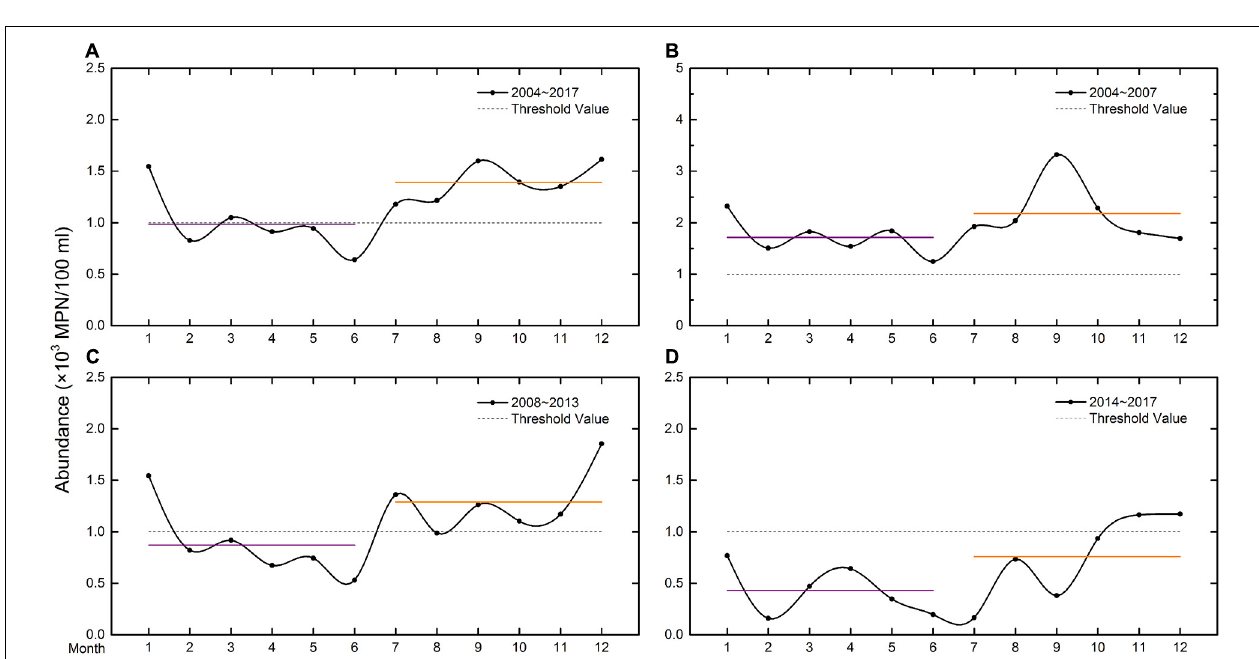
FIGURE 2 | Monthly average abundance ( × 10 3 MPN/100 ml) of CB in Jiaozhou Bay. The red, green, and blue lines show the average abundances from 2004 to 2007, 2008 to 2013, and 2014 to 2017, respectively. The dotted line (threshold value) represents the Class IV standard of CB abundance specified by the NSQS. The bold broken line shows the annual average abundance of CB.